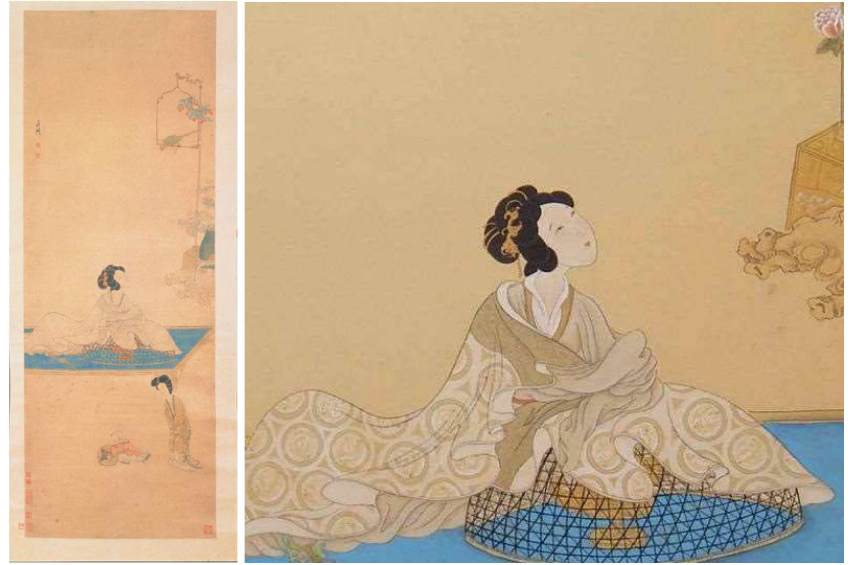
Figure 9. Left: Painting by Chen Hongshou 陳 洪 綬 depicting women using a xun long 熏 籠 (perfume basket), damask silk, 129.6 × 47.3 cm. Shanghai Museum. Right: Detail of the painting.